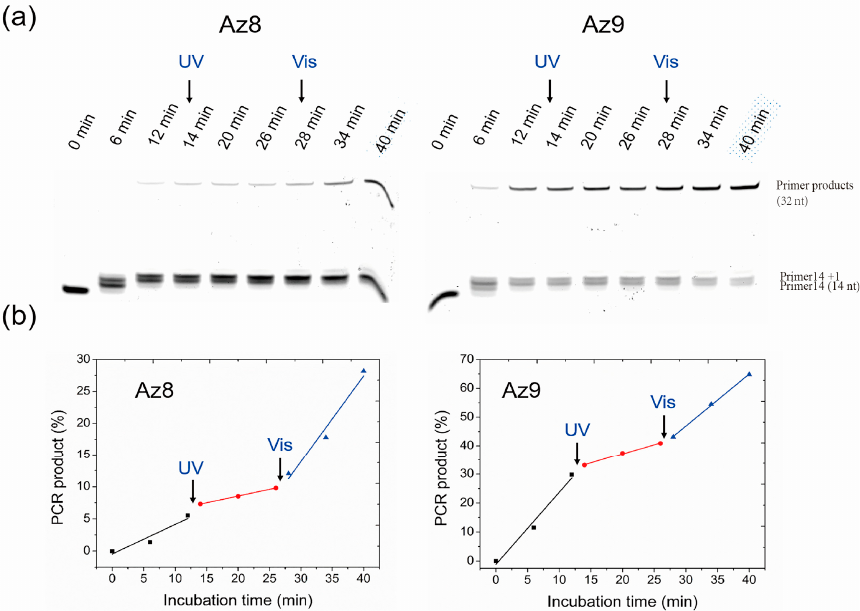
Figure 7. Photoswitching of primer extension using Az8 and Az9 by alternate photoirradiation be- tween UV (2 min) and visible light (2 min). The reaction − mixed solution of 1 μ M FAM-primer and Tem32 template, 1 μ M azobenzene-linked asODNs (Az8 and Az9) was incubated in 1U Taq at